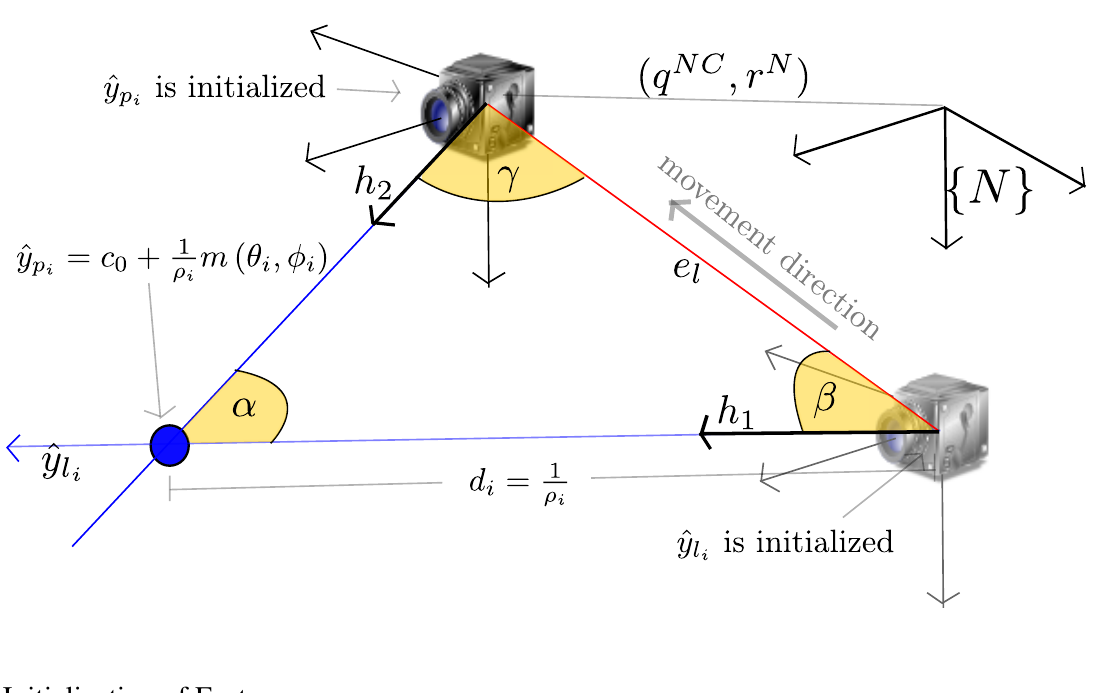
Figure 4. Representation for initialization process of features, ˆ y